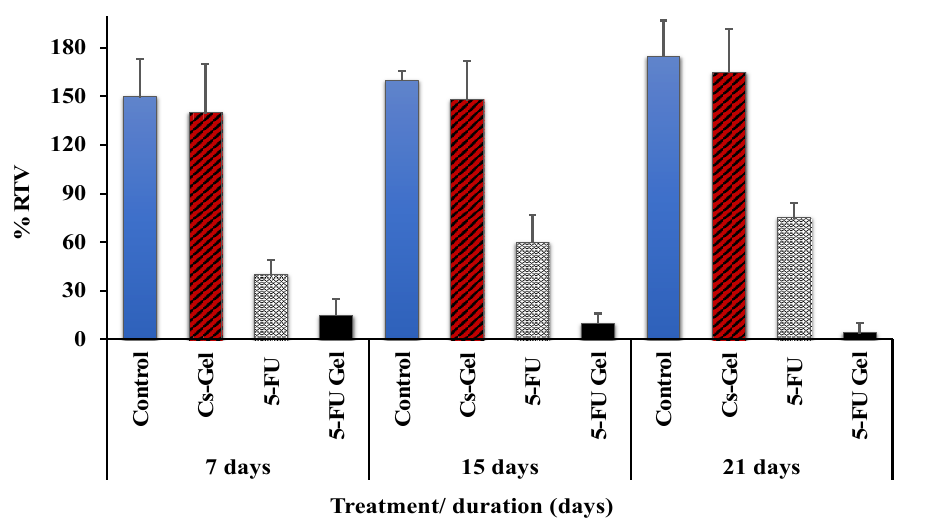
Figure 5. The antitumor activity (RTV; the changes of relative tumor volume) of either 5-FU saline solution or 5-FU-loaded Cs/ β -GP + PL after injection into the breast tumor. ( n = 8).